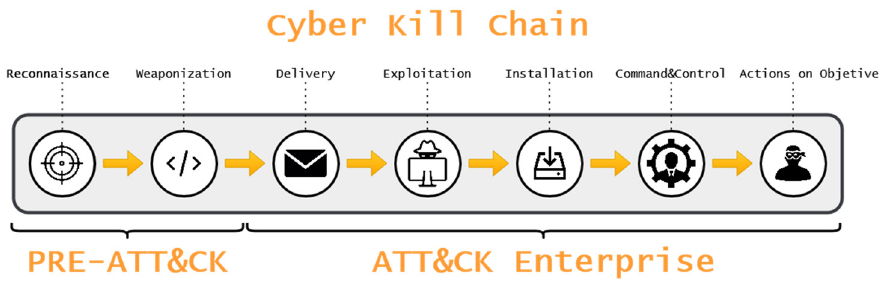
Figure 1. Cyber Kill Chain and MITRE ATT&CK.